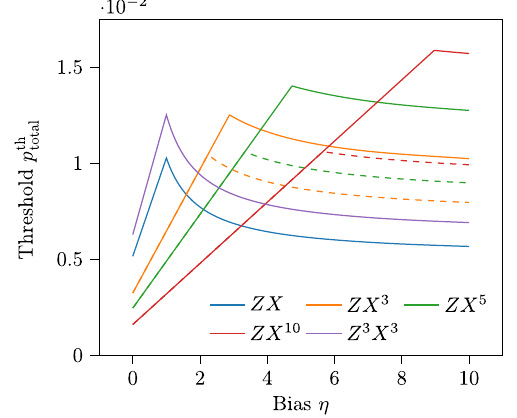
FIG. 15. Threshold p th [see Eq. (9)] as a function of the bias total for different homogeneous schedules and under a circuit-level independent noise model. Dashed lines use the same schedule as the corresponding solid line of the same color, except gauge fixing is not used, for the purpose of